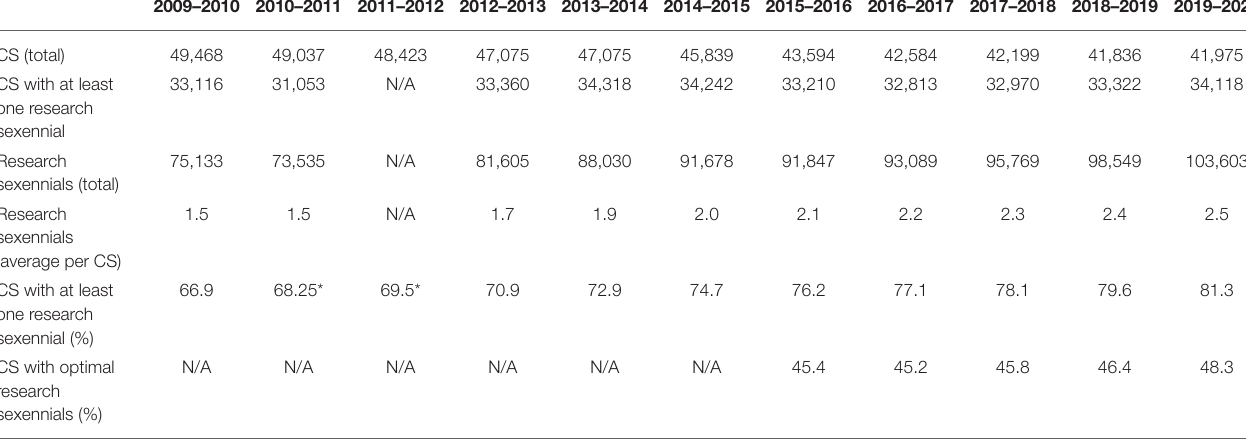
TABLE 4 | Research sexennial statistics. Civil